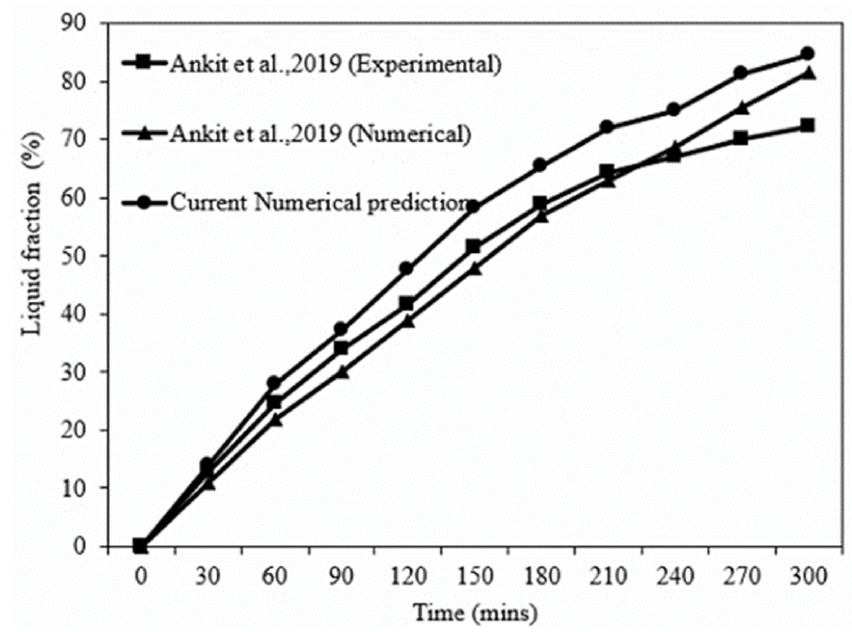
Figure 3. Average liquid fraction during melting of